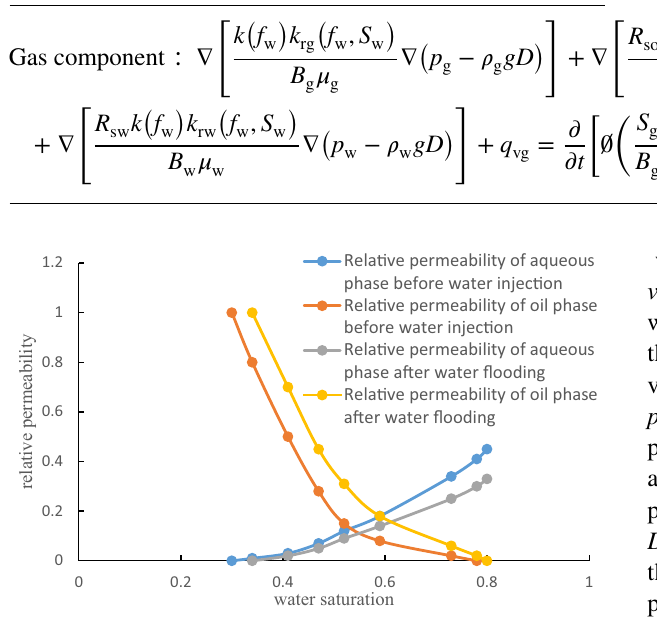
Fig. 3 Relative permeability curve variation with the injection wash out